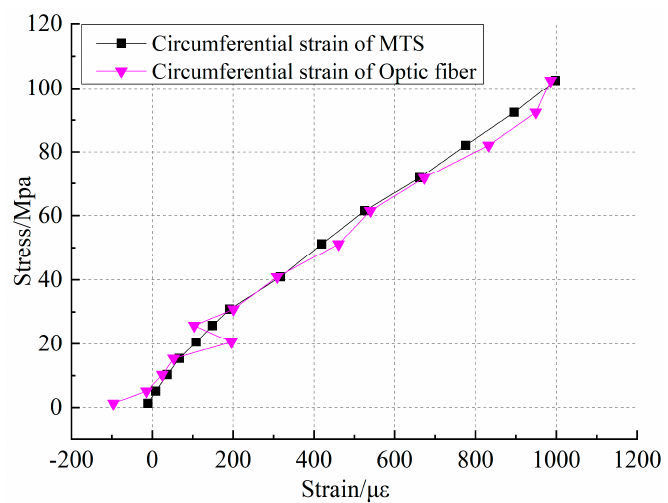
Figure 7. Comparison of circumferential strain between distributed optical fiber and MTS. Sensors 2020 , 20 , x FOR PEER REVIEW 12 of 19